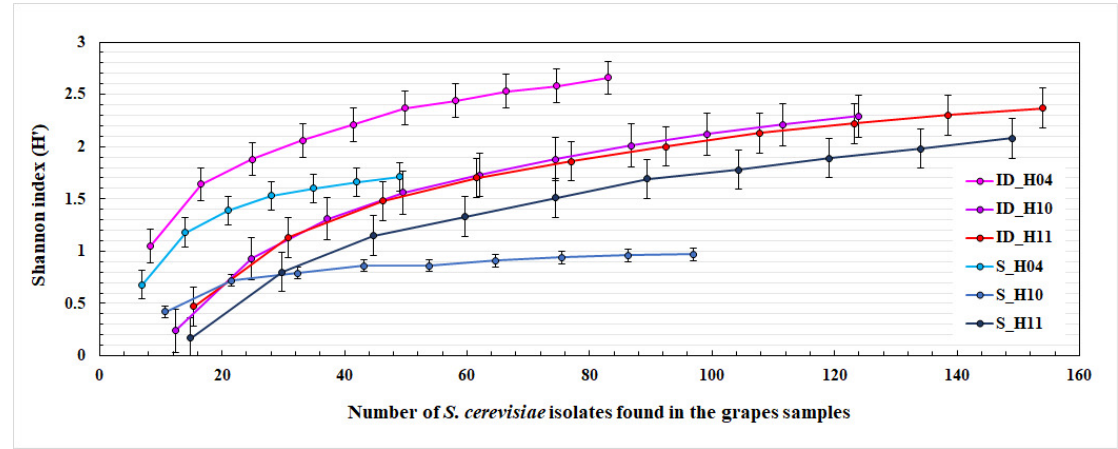
Figure 3. Rarefaction curves of Shannon diversity indices (H’) of the number of S. cerevisiae isolates obtained from the six vineyard S. cerevisiae populations of the ZARM region analyzed. Estimate S software [39] constructed the different curves using a sub-sampling technique, which allows the (balanced) comparison of Shannon indices based on the same number of isolates.